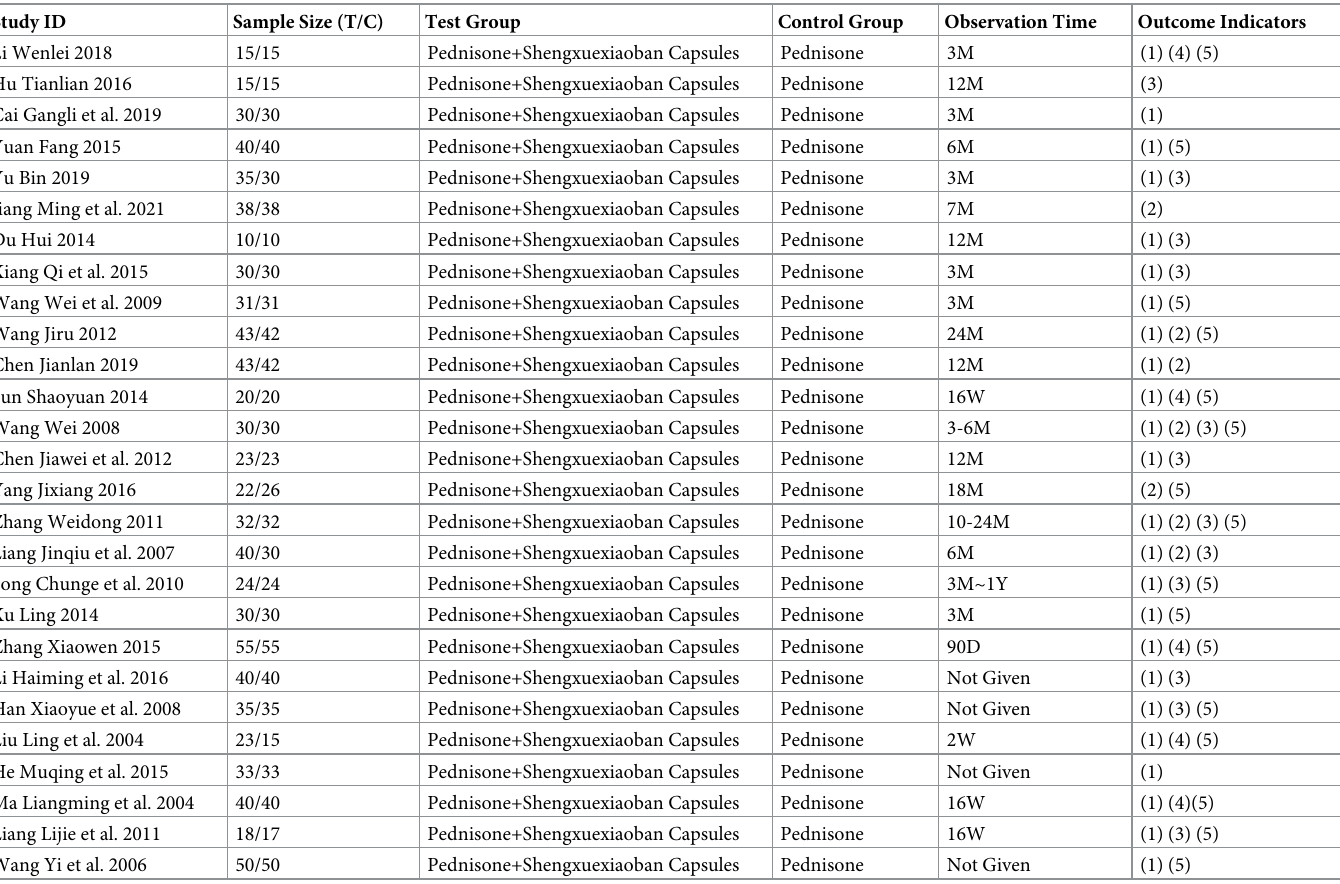
Table 1. Characteristics of randomized controlled trials of shengxuexiaoban capsules in combination with glucocorticoid for ITP. Study